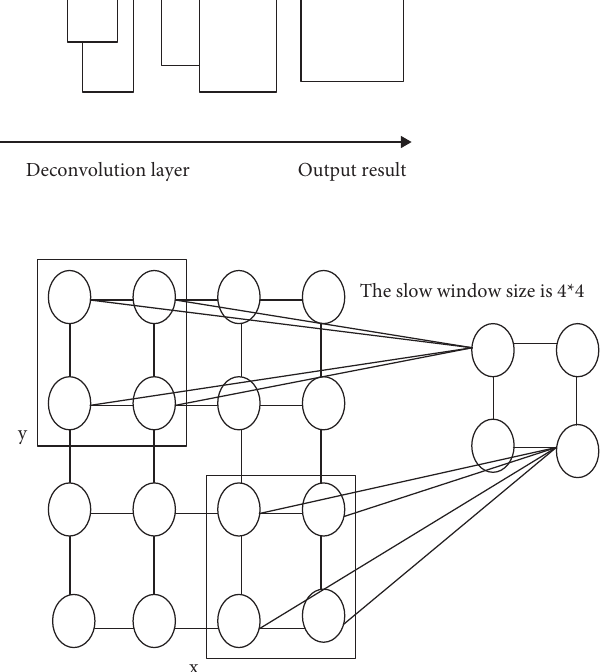
Figure 2: Schematic diagram of maximum